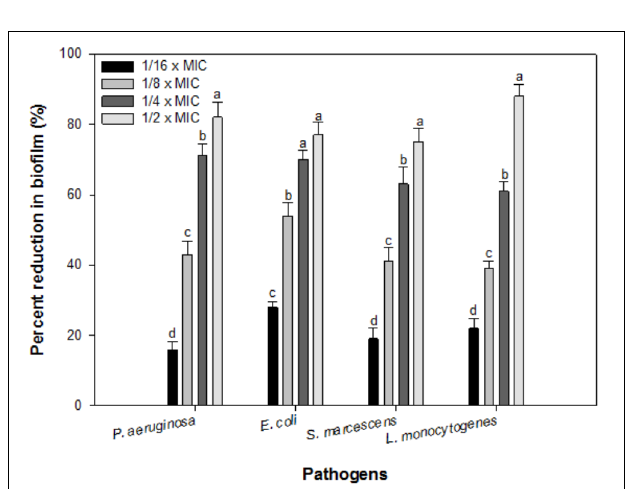
FIGURE 4 | Biofilm inhibition by sub-inhibitory concentrations of IOPNs. Means denoted by the different letter within parameter are significantly different at p > 0.05, using